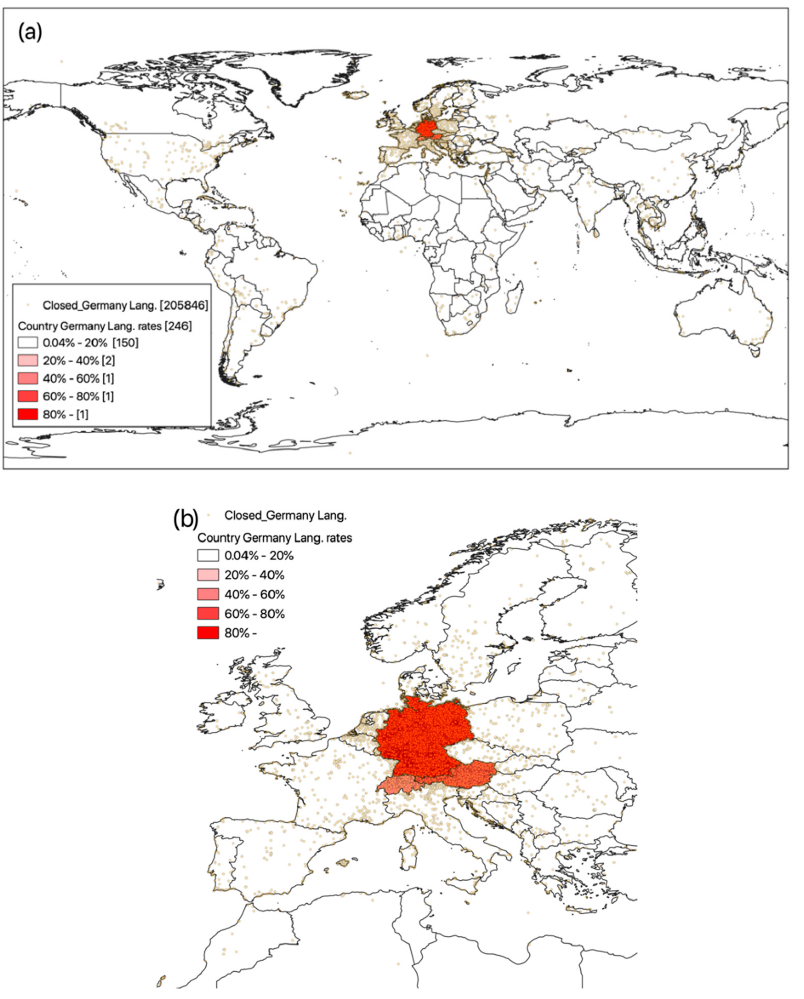
Figure 15. Geographical distribution of closed OSM Notes text using German ( a ) worldwide and ( b ) European countries.